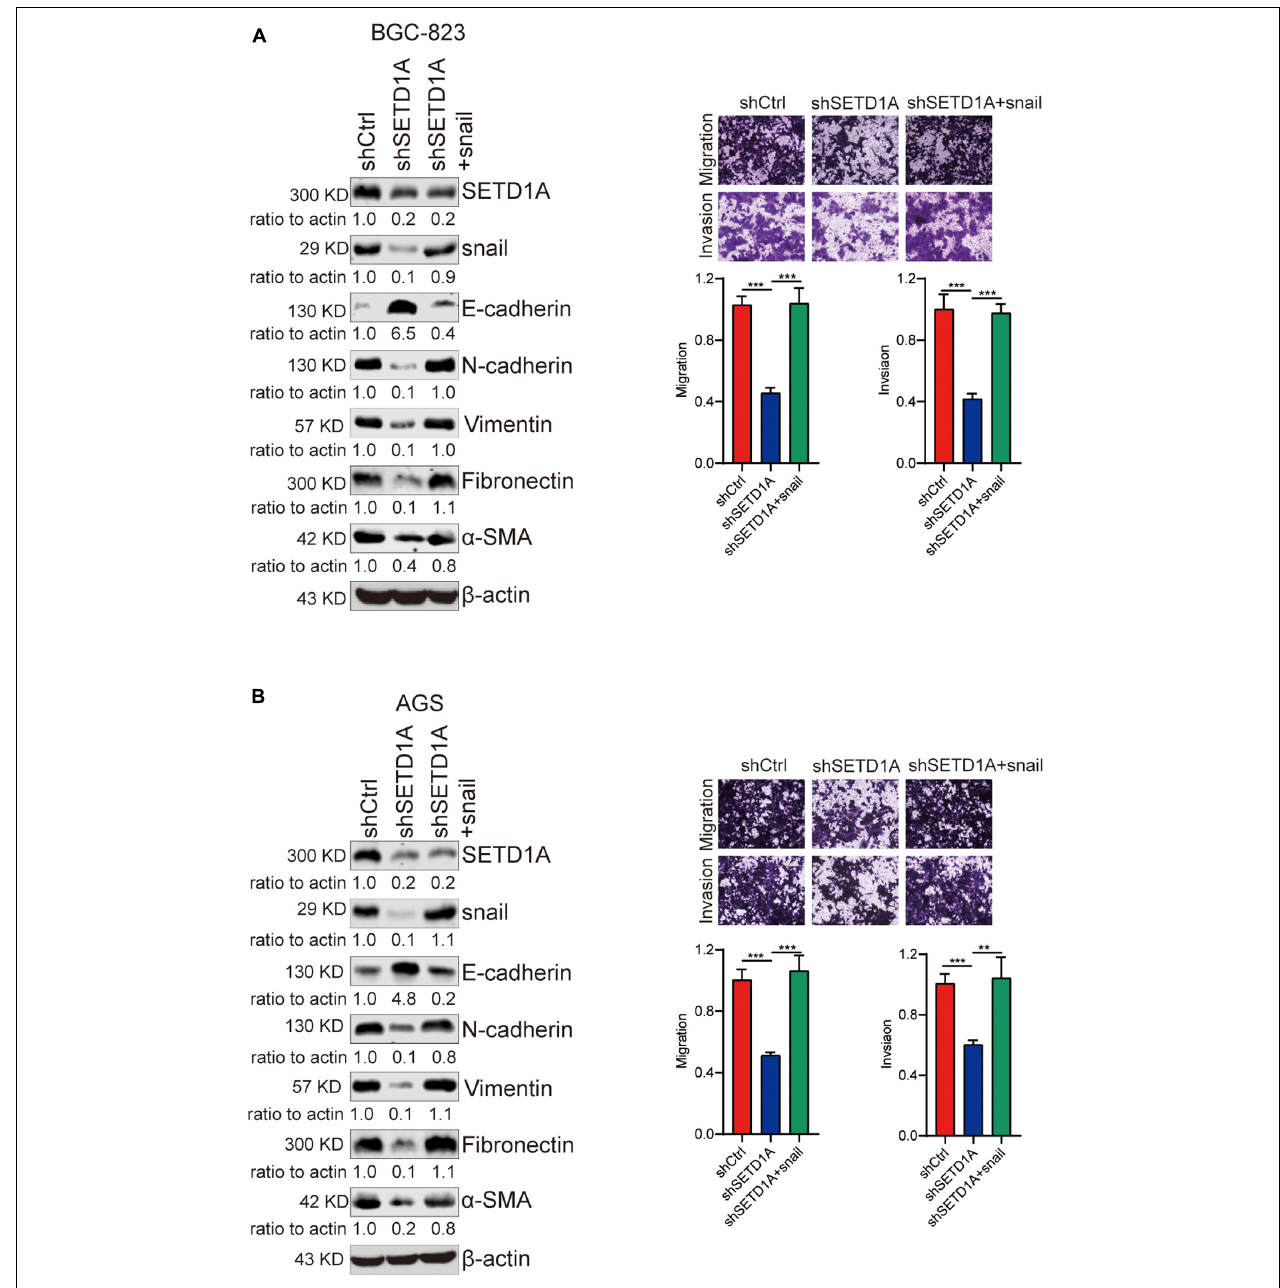
FIGURE 5 | Restoration of snail-associated EMT recovers GC cell migration and invasion inhibited by SETD1A knockdown. (A,B) Restoration of snail resulted in recovering EMT, cell migration, and invasion suppressed by SETD1A knockdown in BGC-823 (A) and AGS (B) cells. Data from three replicates are shown as the means ± SD. ** p < 0.01, *** p < 0.001 by Student’s t- test.